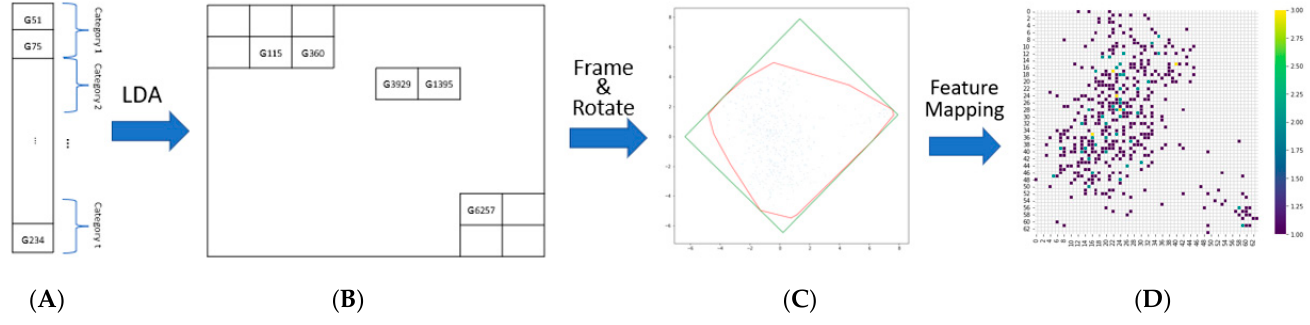
Figure 2. Locating the genes in the 2D image by linear discriminant analysis. ( A ) Categorization of the genes. ( B ) The location of the genes in a 2D image obtained by LDA. ( C ) The minimum rectangle obtained from ( A ). ( D ) The gene expression placed at the corresponding location.